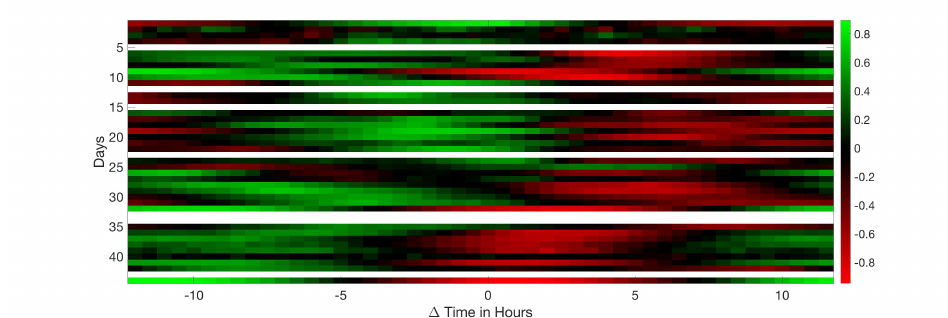
Figure 16. Results of the circular correlation CO 2 —temperature. Horizontal axis corresponds to the ∆ Time measured in hours, evaluating the delay between CO the days of the cycle.